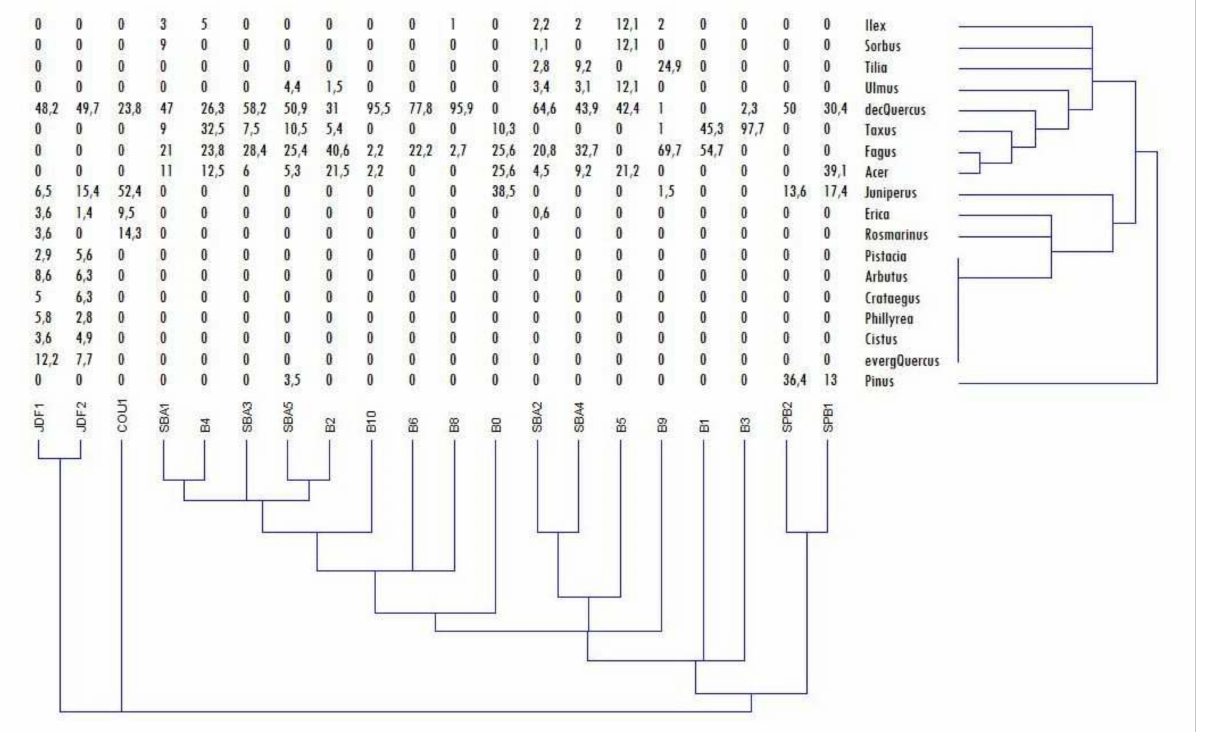
Figure 3. Cluster analysis based on Euclidean similarity